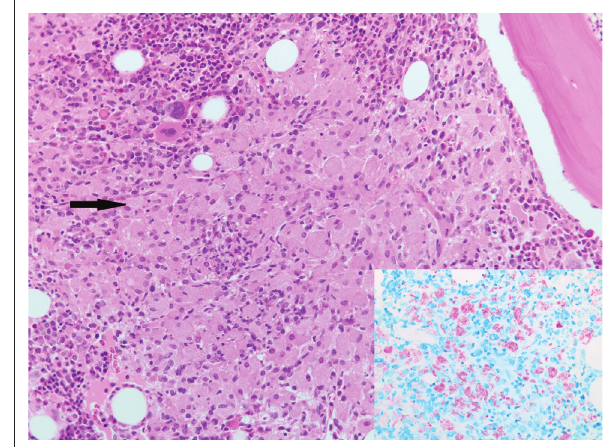
FIGURE 2: Skin biopsy with numerous extracellular yeasts on haematoxylin and eosin (original magnification × 200), the inset shows the yeasts with blue capsules and pink cell walls on Alcian Blue Periodic Acid Schiff stain (original magnification × 400).